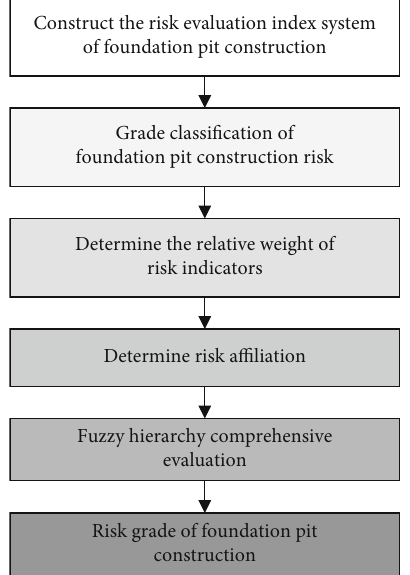
Figure 1: Fuzzy hierarchy comprehensive evaluation process of foundation pit construction